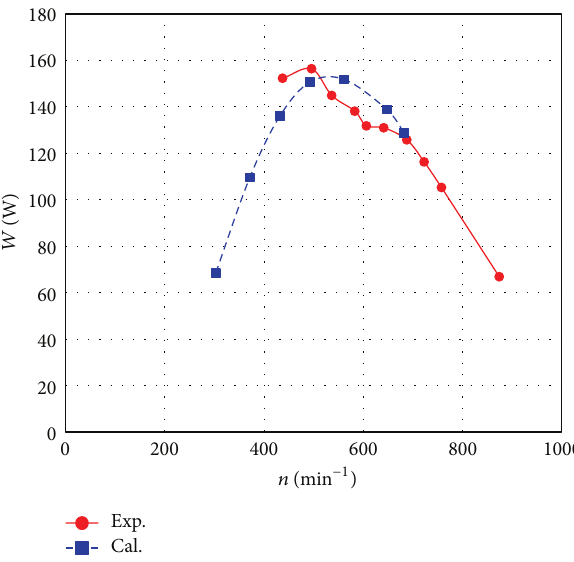
Figure 23: Correlation between the rotational speed and the output